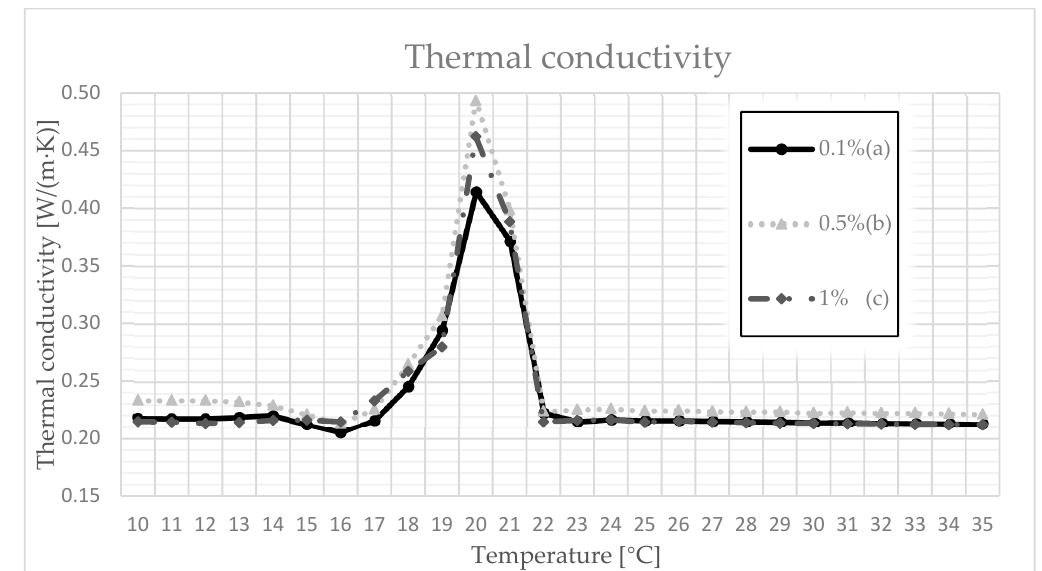
Figure 3. Thermal conductivity as a function of temperature for (a) 0%; (b) 0.1%; (c) 0.5%; (d) 1% polymer content.